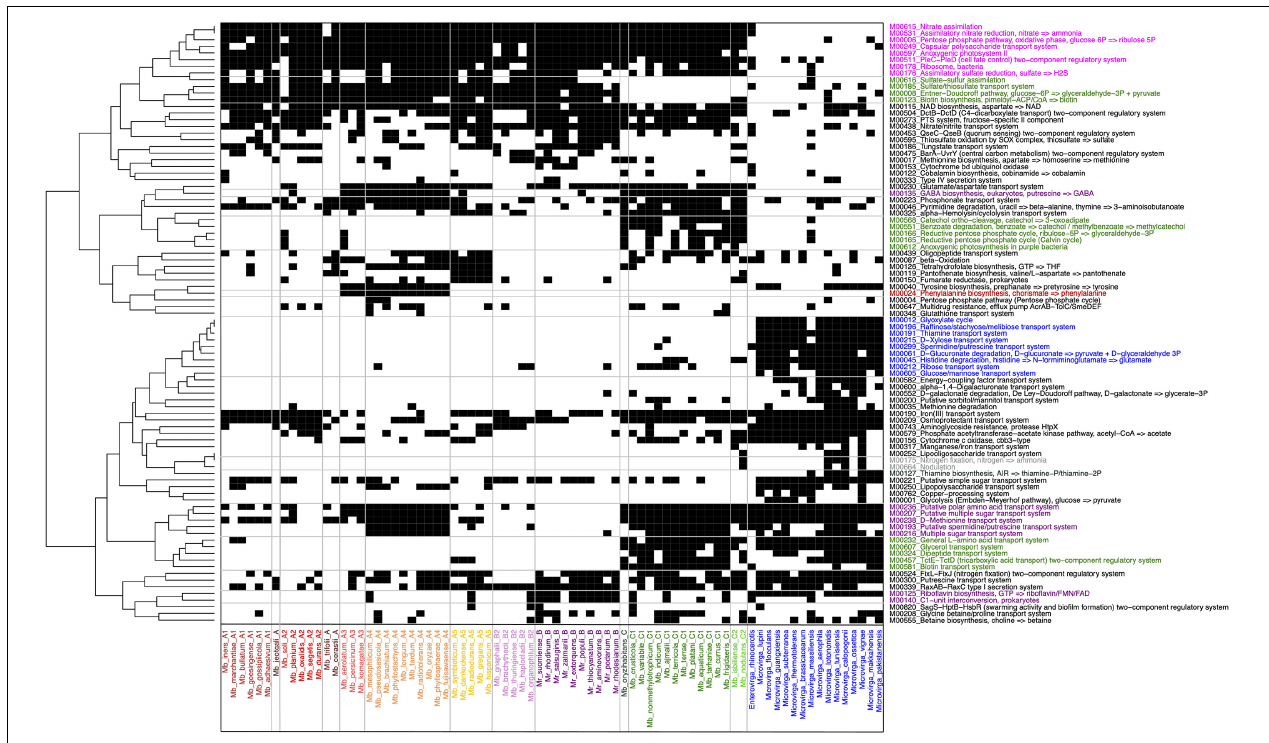
FIGURE 4 | The presence and absence of functional modules and pathways found in PPFMs and the other Methylobacteriaceae strains analyzed using the Genomaple pipeline. The presence and absence matrix (1/0) is presented in black and white, respectively. KEGG modules ID and pathways names are shown on the right. Colors: pink, specific to PPFM species; blue, specific for Microvirga spp.; red, specific to A3 and A4; purple, specific to B, B2, and some species from A subclades; green, specific to clade C among PPFMs; and gray, nitrogen fixation and nodulation genes found in Mb. nodulans ORS 2060 T